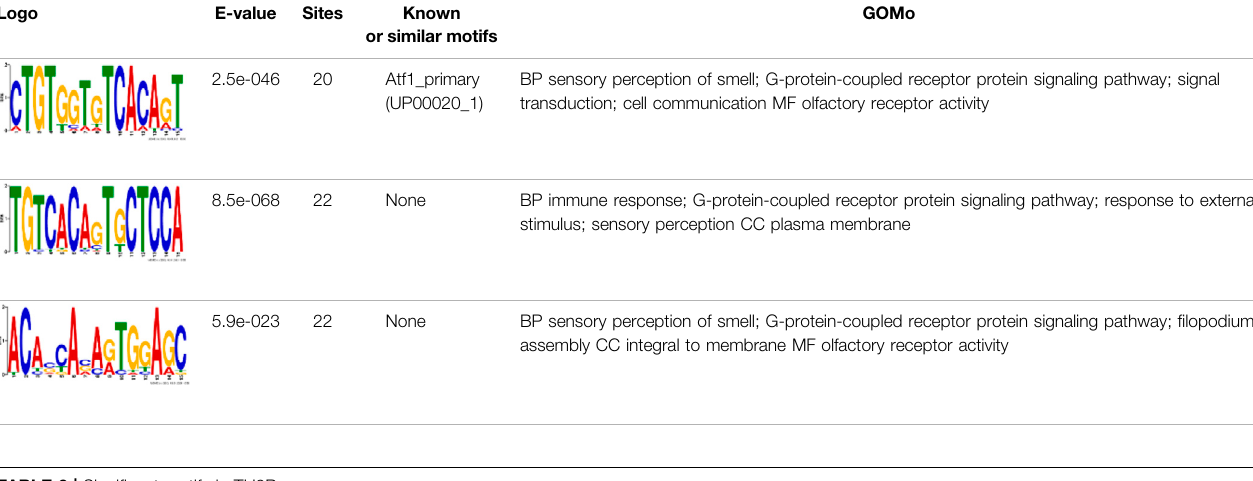
TABLE 2 | Signi fi cant motifs in TH2B sequences. Logo E-value Sites Known